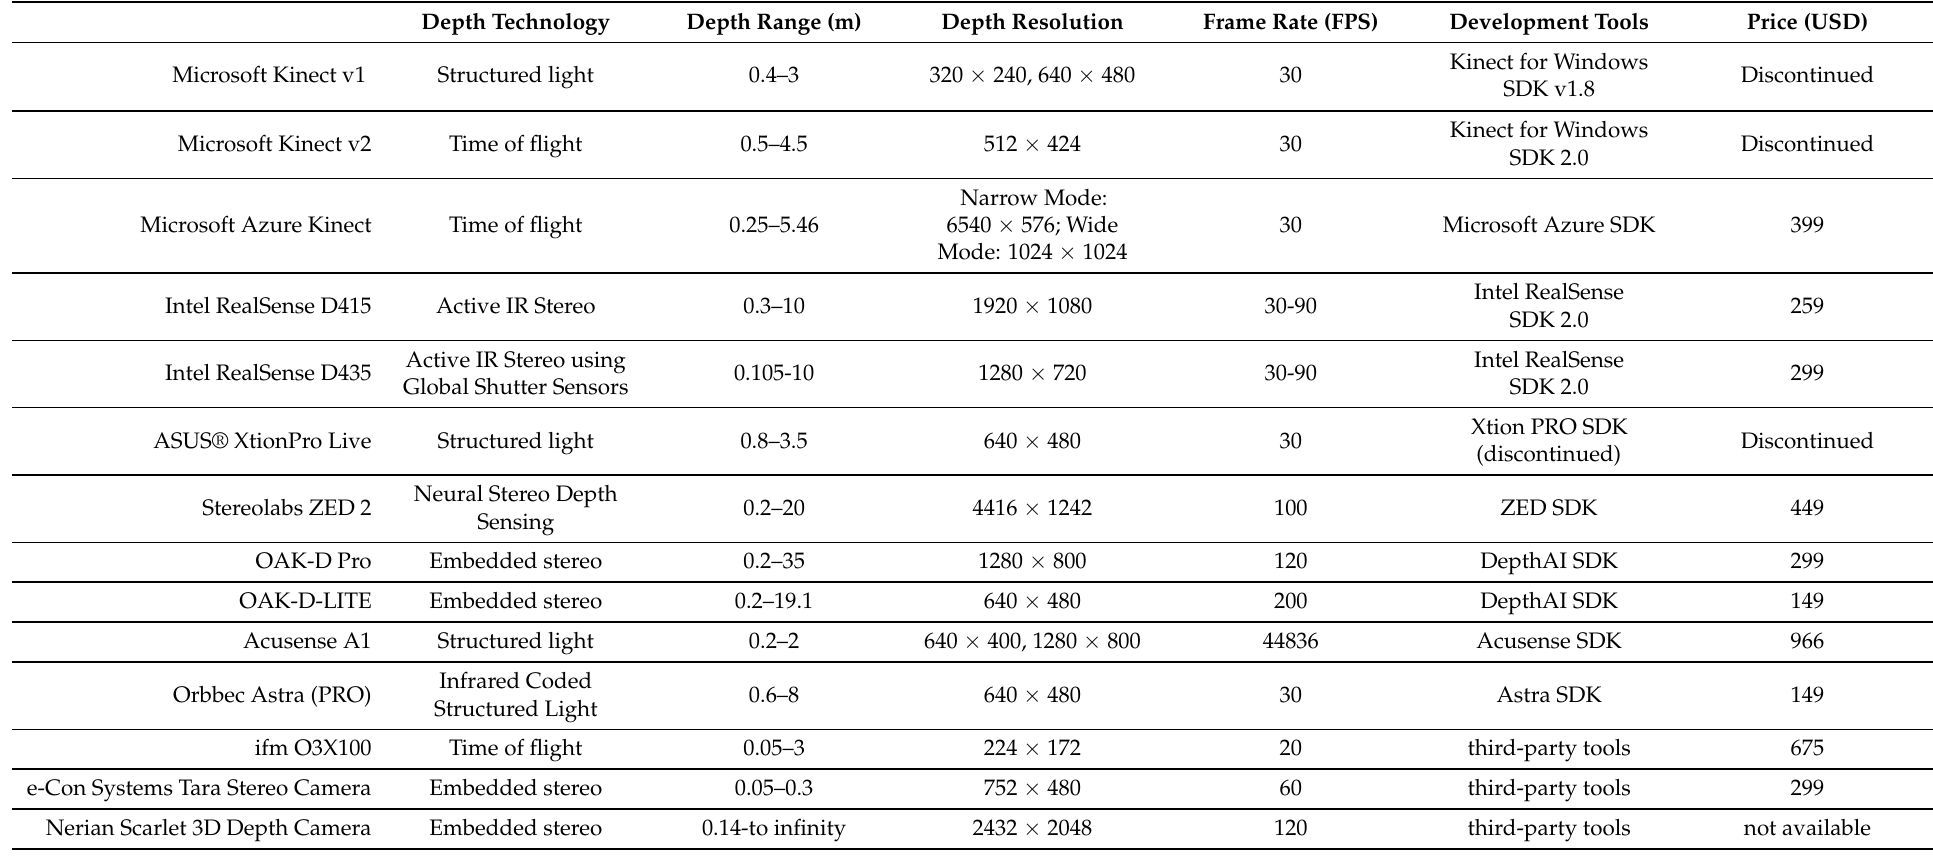
Table 5. Comparison of the main depth devices (prices last updated in March